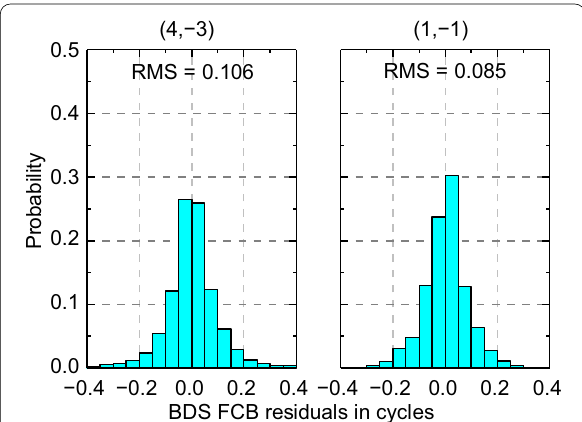
Fig. 5 Histogram of the BDS-2 FCB residuals in the NL and WL linear combinations